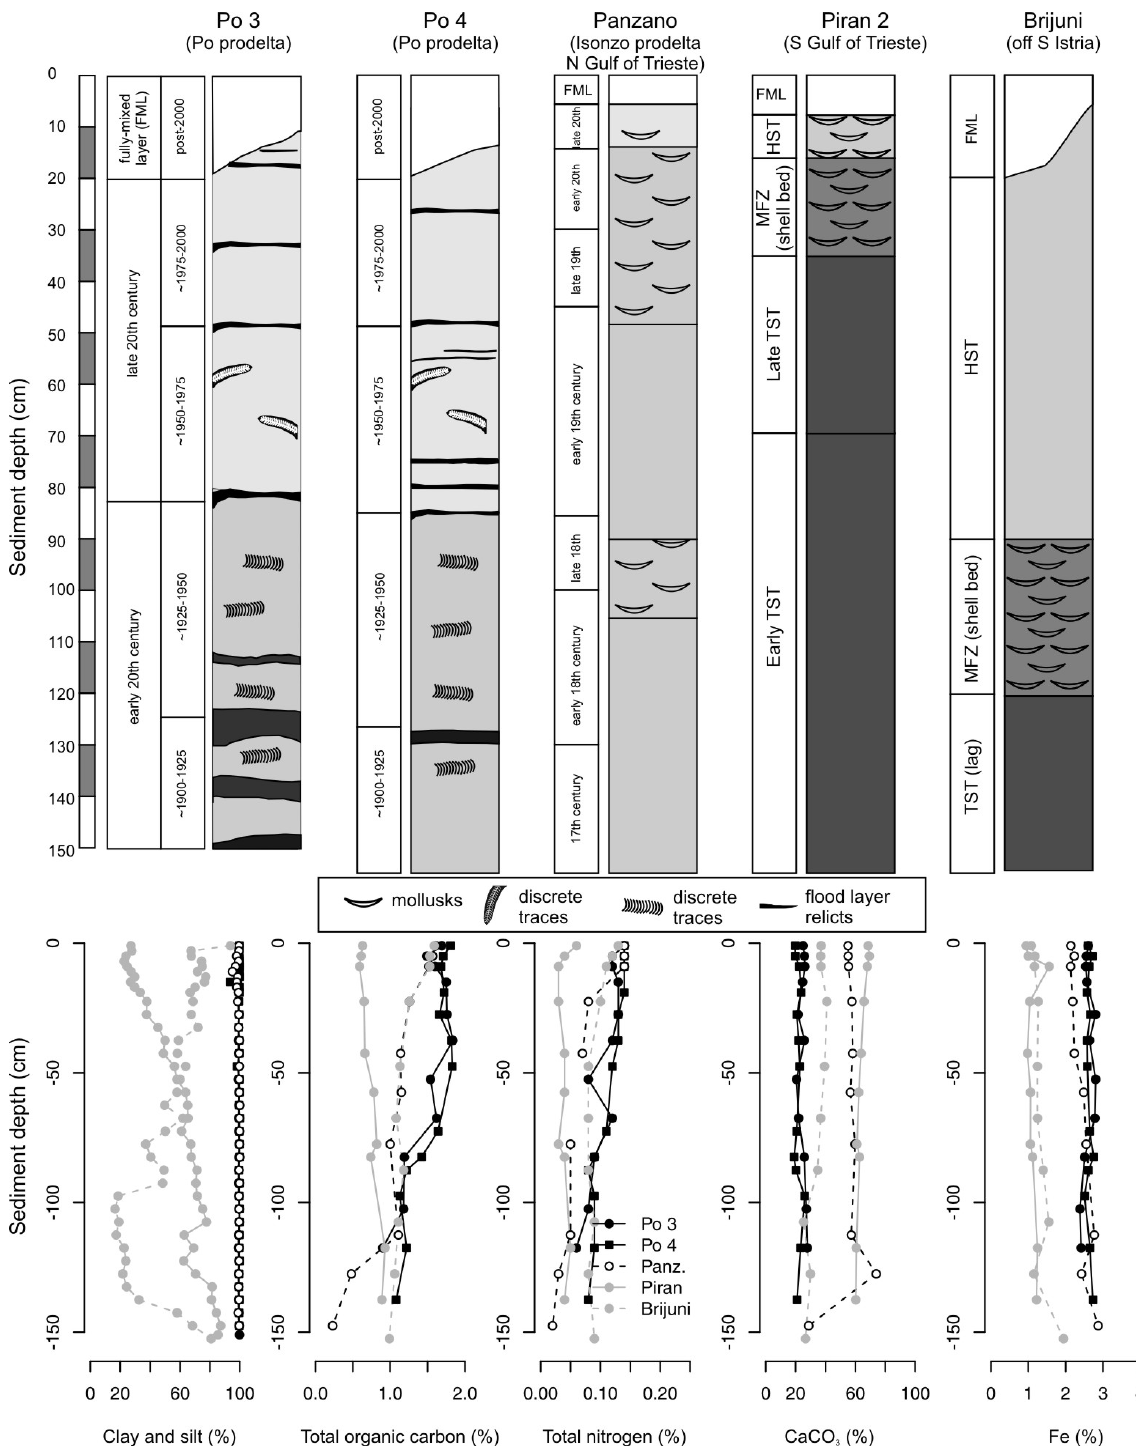
Figure 2. Top row: lithologic sections through sediment cores at five locations, with the highest sedimentation rate (1–2cmyr − 1 ) at the Po sites, intermediate net sedimentation rate (0.2–0.4cmyr − 1 ) in the Bay of Panzano, and very slow sedimentation rate at Piran and Brijuni ( ∼ 0.01cmyr − 1 ), with chronostratigraphic and sequence stratigraphic subdivisions. TST – transgressive system tract, MFZ – maximum flooding zone, HST – highstand system tract, FML – fully mixed layer (its thickness varies within cores depending on differences between the estimates based on 210 Pb profiles and downcore changes in median shell age). Bottom row: stratigraphic trends in grain size, in the weight percent of total organic carbon (TOC), total nitrogen (TN), CaCO 3 (based on total inorganic carbon), and iron also discriminate between sites with higher sedimentation (Po and Panzano) and sites with slower sedimentation (Piran and